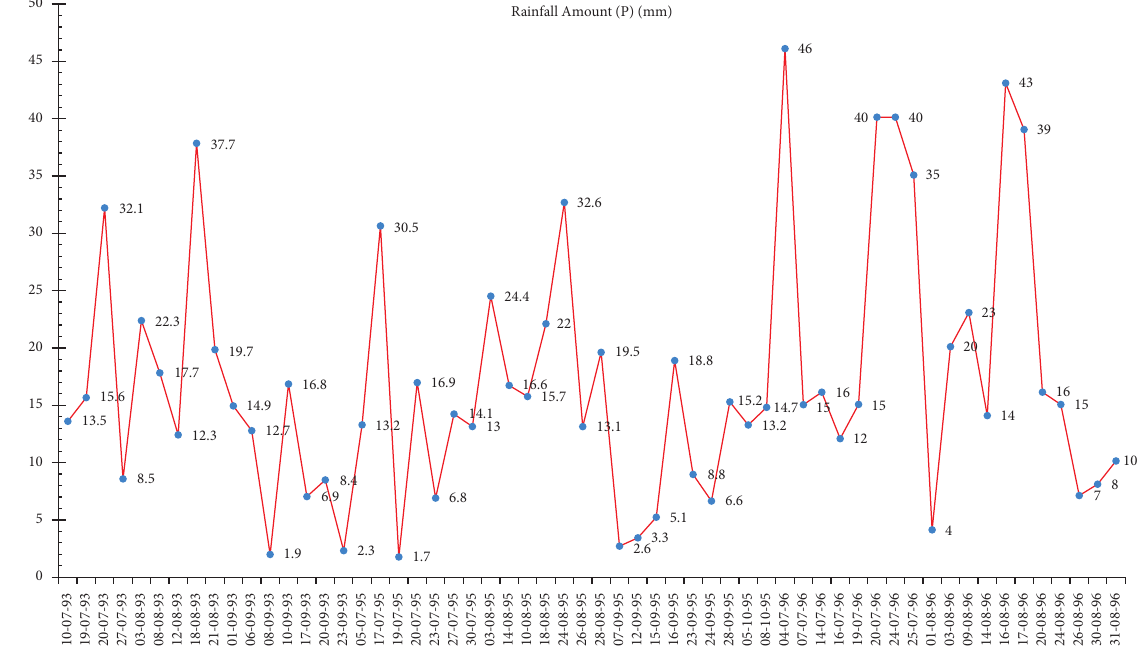
Figure 3: Rainfall amount with the selected dates of observation.